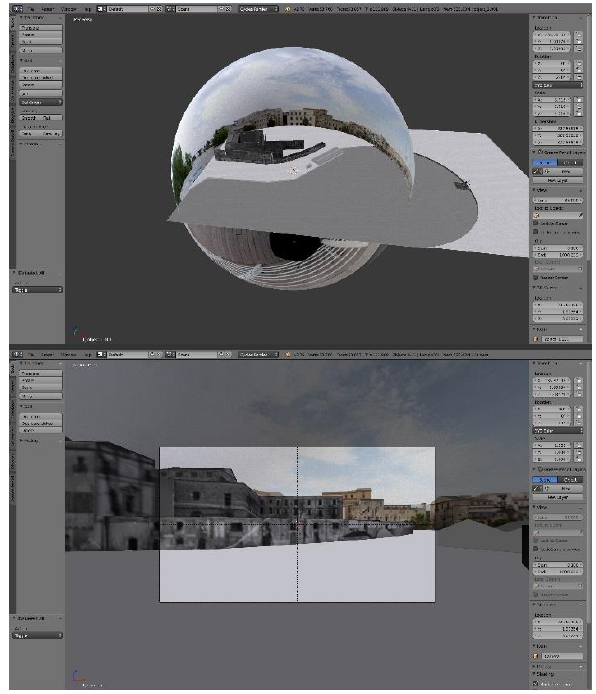
Figure 17: Real and virtual image are mixed in Blender.